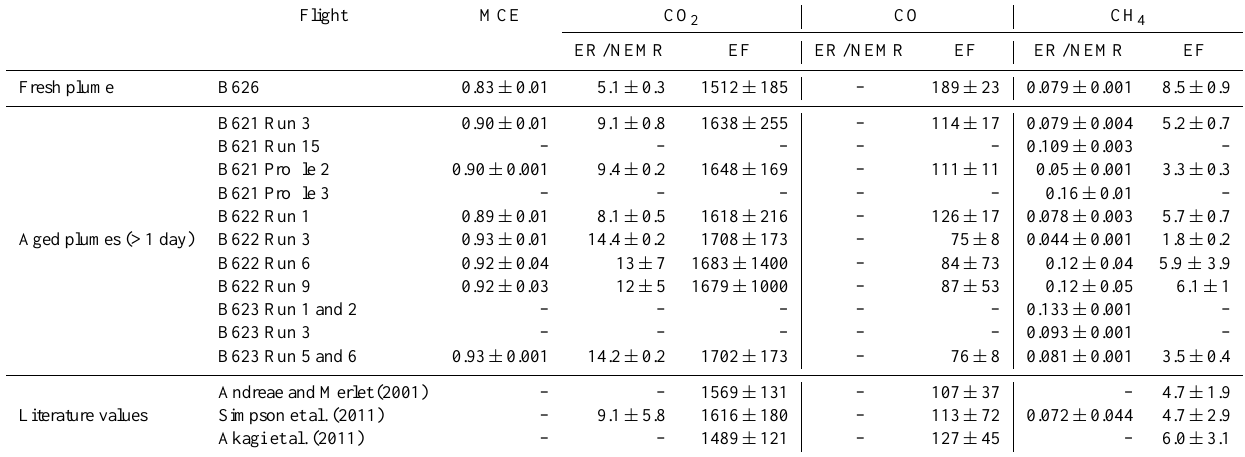
Table 2. Emission ratios (ER), normalised excess mixing ratios (NEMR) and emission factors (EF) determined by sampling boreal biomass burning plumes over eastern Canada. MCE is the modified combustion efficiency, a measure of the combustion phase of the fire. The ER and EF determined in this study show good agreement with previous studies in boreal regions. Andreae and Merlet (2001) and Akagi et al. (2011) have compiled values from the literature for extra-tropical forests. Simpson et al. (2011) report values for forest fires in boreal Canada made as part of the ARCTAS project. Units are (mol(molCO) − 1 ) for the NEMR/ERs and g (kg dry matter) − 1 for the EFs. Runs are when the aircraft does not change altitude and profiles are when there is a change in